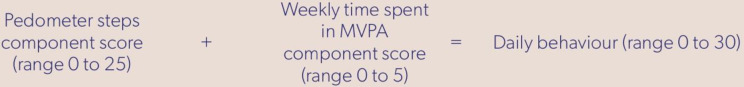
Formula for computing the daily behaviour score.Reprinted from www.capl-eclp.ca/capl-manual under a CC BY license, with permission from Healthy Active Living and Obesity Research Group, original copyright 2017.